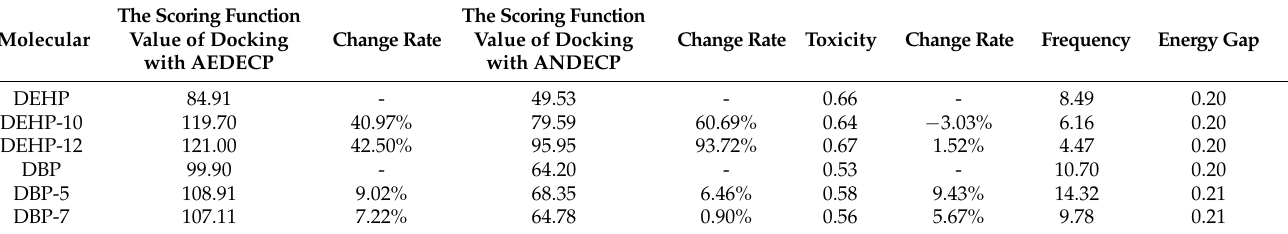
Table 4. Molecular degradability, toxicity, and functional verification of PAE